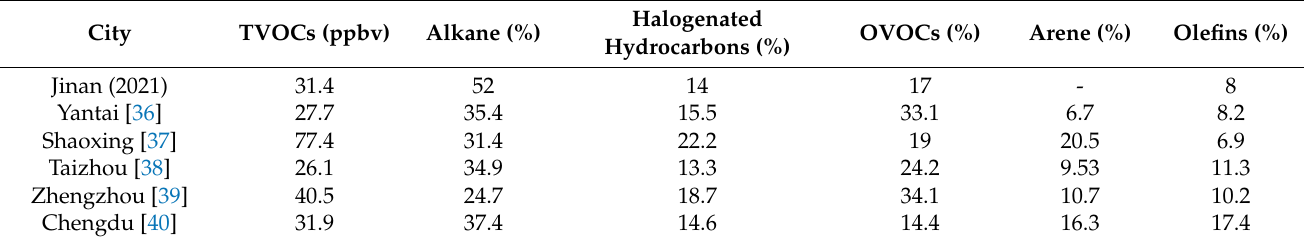
Table 2. Comparison of the VOC components in Jinan and other